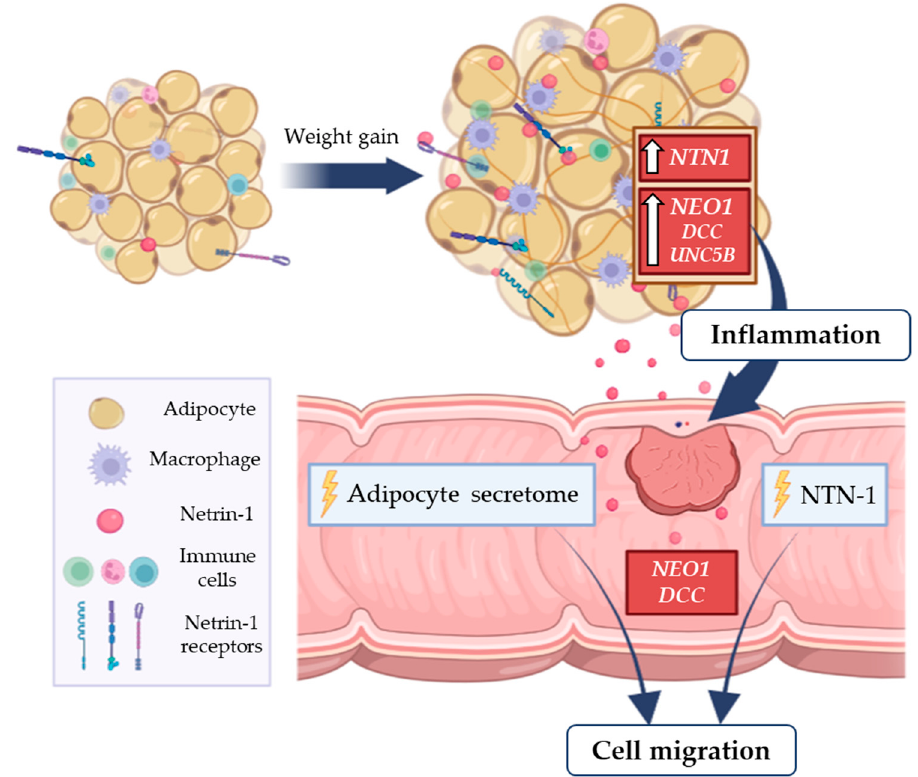
Figure 6. Obesity-associated chronic low-grade inflammation is related with increased risk of colon cancer. In this context, the increased gene expression levels of the pro-inflammatory factor NTN1 and its receptor NEO1 in VAT from patients with OB and CC promote a pro-inflammatory microenvironment that may favour tumour progression. The treatment of a colorectal adenocarcinoma cell line with NTN-1 and with the ACM from patients with OB promoted tumour cell migration, emphasising a key role of NTN-1 in CC progression. CC, colon cancer; DCC , deleted in colorectal carcinomas; NEO-1 , neogenin-1; NTN1, netrin-1; OB, obesity; UNC5B , uncoordinated-5 homolog B; VAT, visceral adipose tissue.